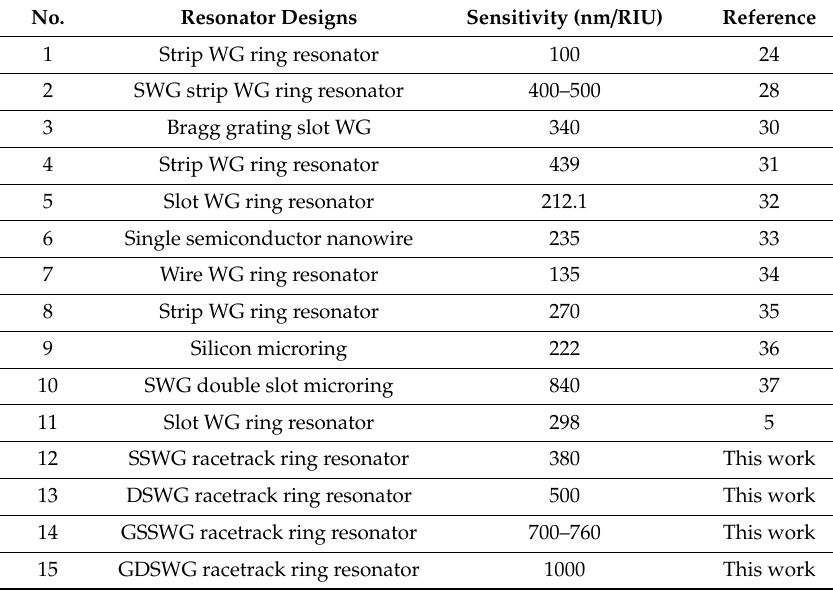
Table 3. Previously reported sensitivities of SOI ring resonators.